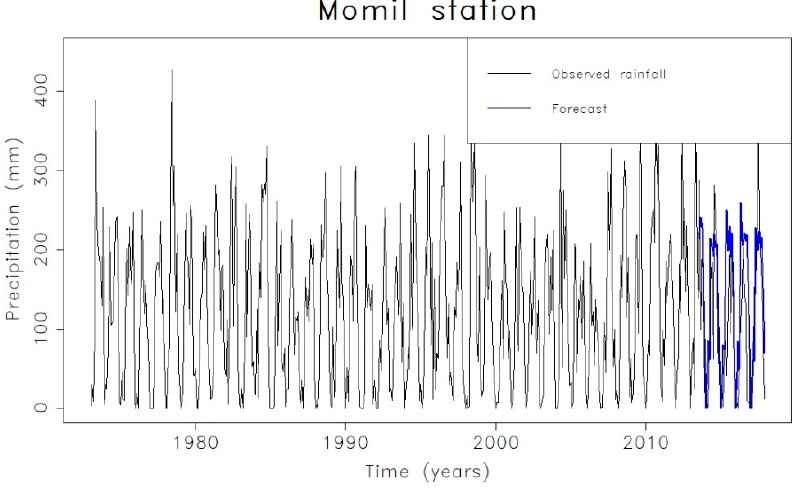
Figure 10. Model prediction versus the observed values.